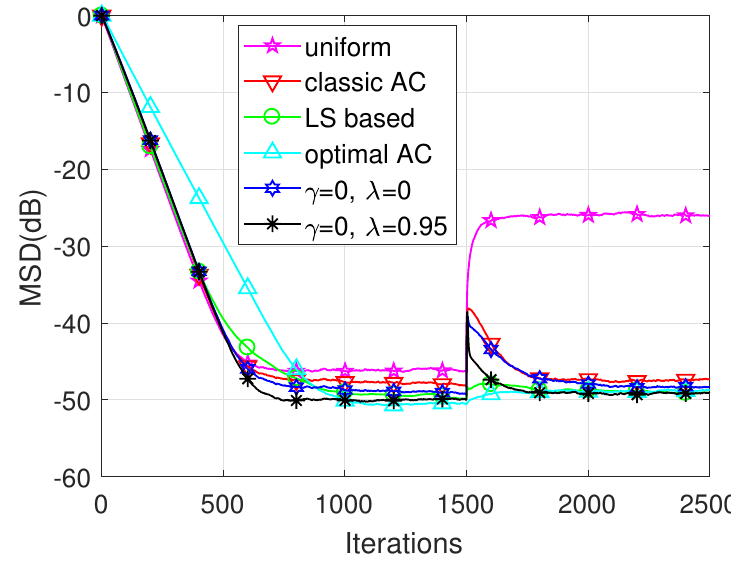
Figure 2. The MSD learning